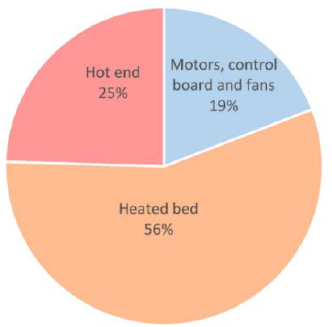
Figure 2. Distribution of the energy use of the printer [9].